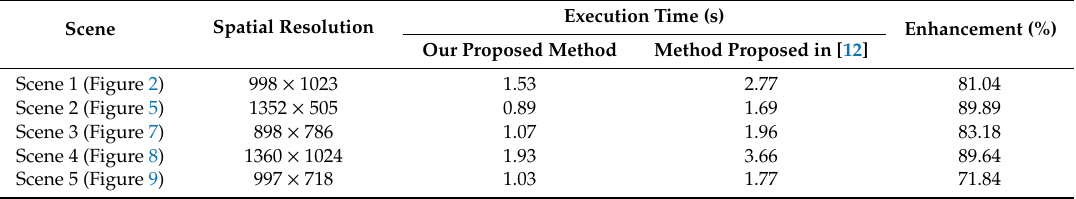
Table 1. Comparison of the process time for two polarimetric dehazing methods.